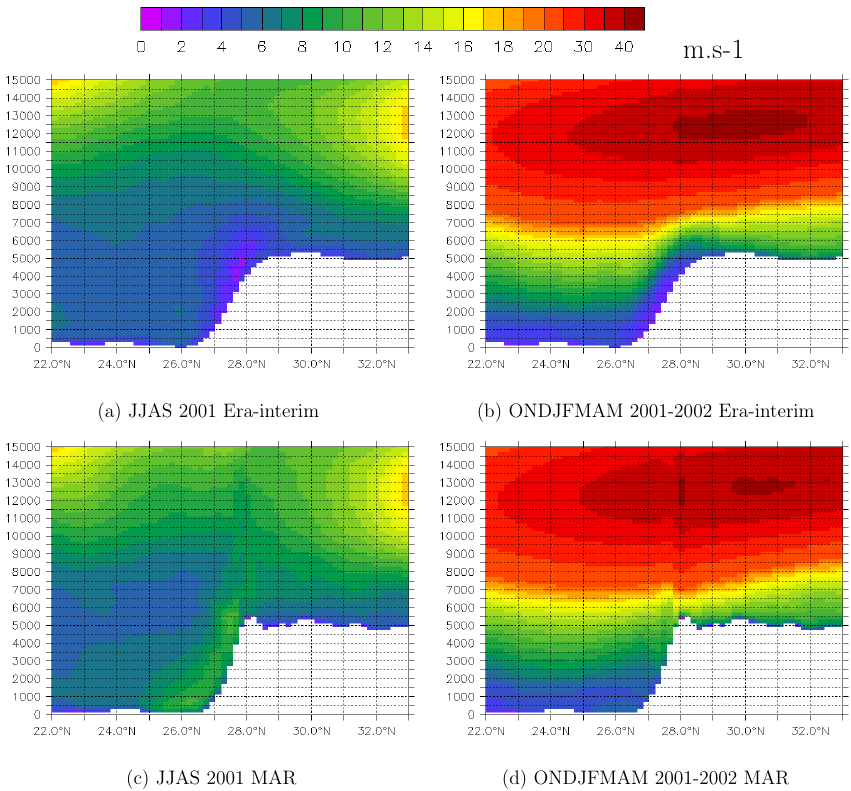
Fig. 2. Wind intensity temporally averaged at the longitude 86 ◦ E: estimated from the ERA-INTERIM during (a) monsoon (JJAS) 2001, (b) extra-monsoon period (ONDJFMAM) 2001–2002, and simulated with MAR during (c) monsoon (JJAS) 2001 and (d) extra-monsoon period (ONDJFMAM)